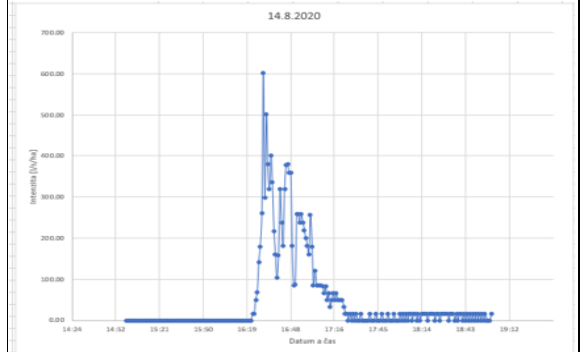
Figure 7. Cloudburst rainfall from 14.8.2020